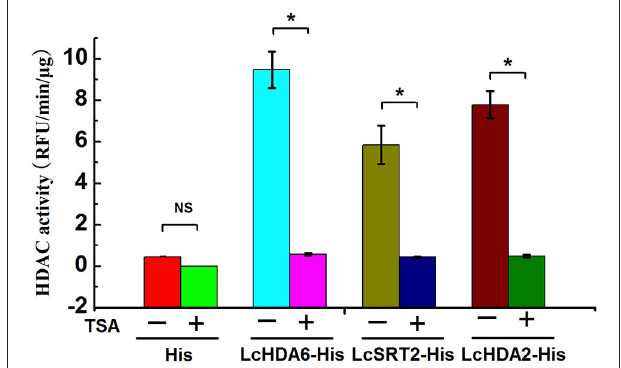
FIGURE 10 | In vitro assay of HDAC activity of LcHDA2, LcHDA6, and LcSRT2. His protein alone was used as control, TSA was added to samples to demonstrate the specificity of deacetylase activities. − and + represent the absence or presence of TSA, respectively. The HDAC activity was expressed by relative fluorescent intensity using a fluorescence microplate reader at 355 EX /460 EM . Data shown are means ± SD. One-way ANOVA (Tukey-Kramer test) analysis was performed, and statistically significant differences ( P < 0.05) were indicated by